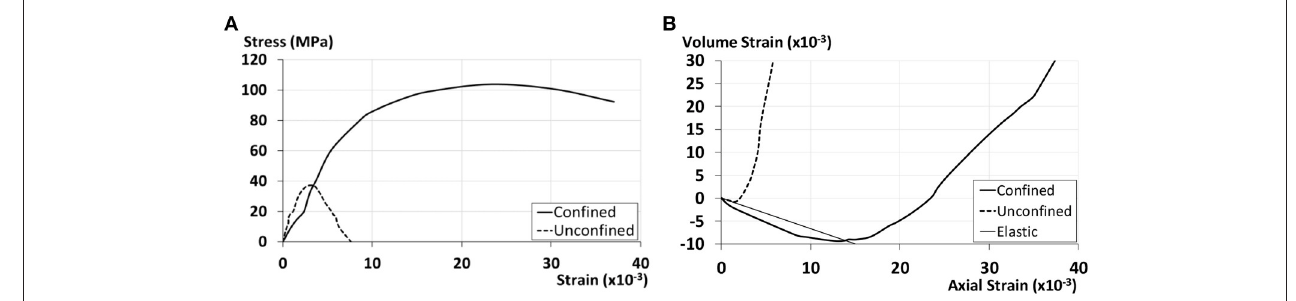
FIGURE 6 | Constitutive law for confined concrete (Pantazopoulou and Mills, 1995): (A) stress - strain relationship, (B) volumetric strain - axial strain relationship.